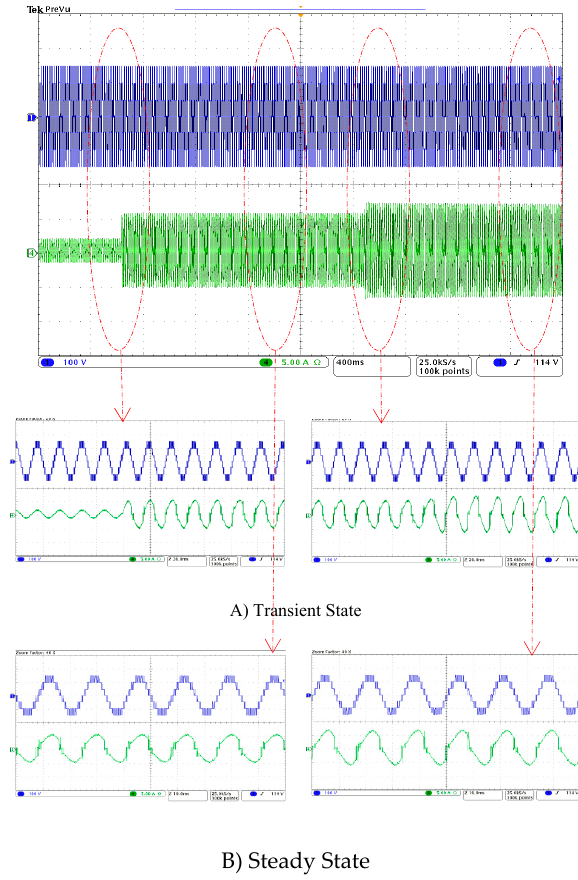
Figure 7. Output voltage and current waveform of MPUC inverter when different loads are added step by step. Ch 1 : V ab , Ch 4 : i l . ( A ) Transient state when nonlinear load is added to the RL load (left) and after a while a motor load is added to the system (right); ( B ) steady state when a nonlinear load is added to the RL load (left) and after a while a motor load is added to the system